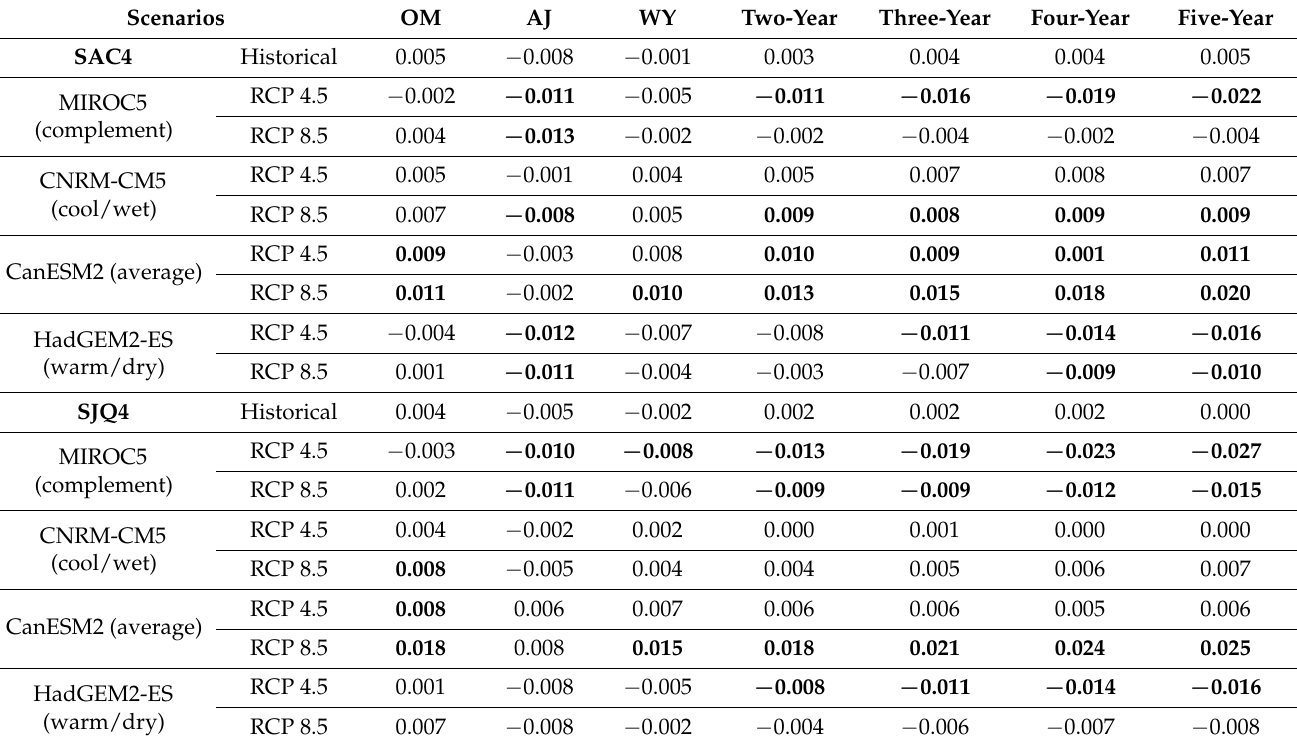
Table 1. Trend slope of SSI indices (numbers in bold indicate statistically significant